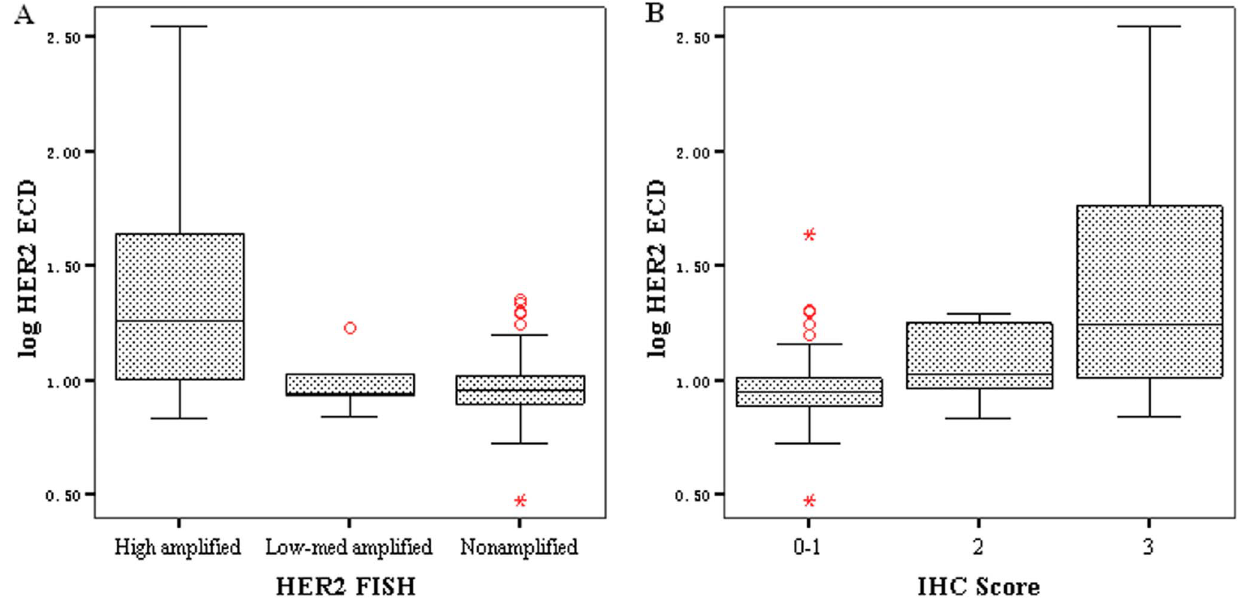
Figure 2. Serum HER 2 ECD levels stratified by different levels of tissue HER 2 amplification or expression. The median HER 2 ECD level was significantly higher in patients with high levels of HER 2 amplification than in patients with low to moderate levels of amplification or no amplification (A). The median HER 2 ECD level was significantly higher in patients with HER 2 IHC 3 + than in patients with HER 0–2 + (B).